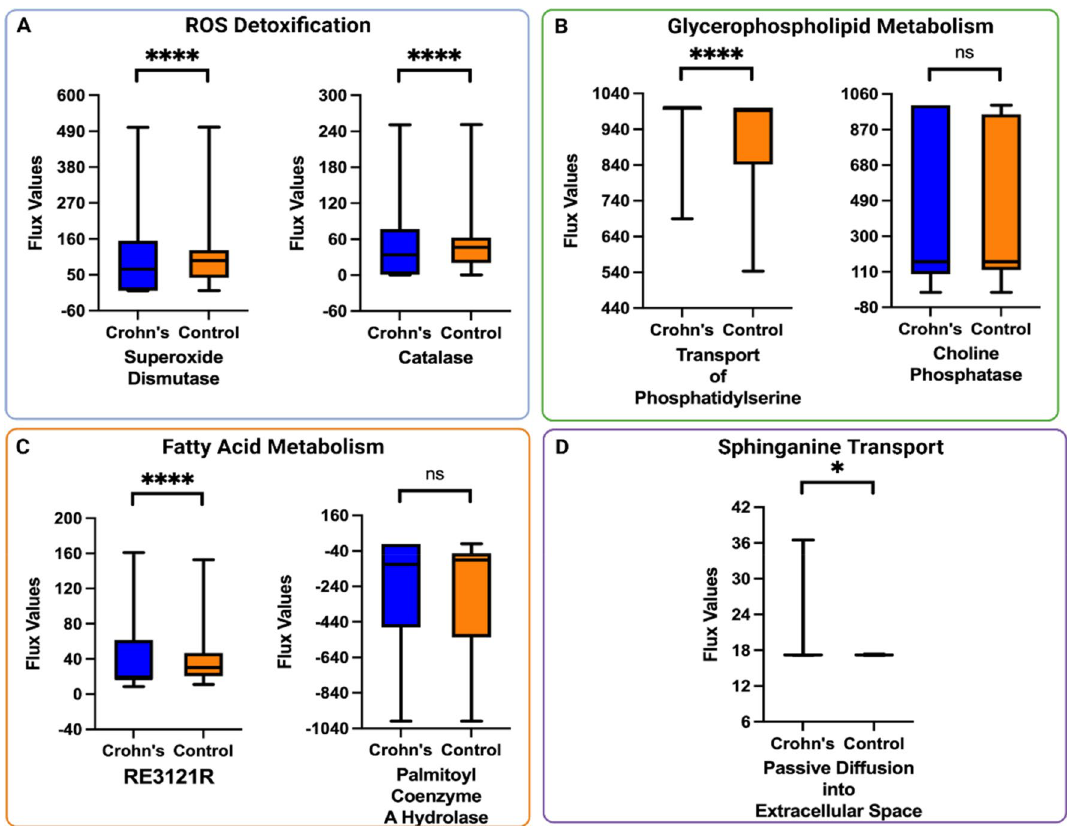
Figure 3 . Metabolic pathways with an altered flow in enteroids generated from patients with Crohn’s disease (CD) versus control patients: Our Flux Balance Analysis/Random Forest framework was applied to RNA sequencing data from enteroid models generated from n = 16 patients with Crohn’s disease and n = 12 healthy controls. After obtaining the list of top metabolic reactions that were altered between the CD and control groups, these reactions were grouped into "families" ( A–D ) based on the biological processes they were involved in. ( A ) ROS detoxification: superoxide dismutase and catalase, ( B ) Glycerophospholipid metabolism: choline phosphatase and the transport of phosphatidylserine. ( C ) Fatty acid oxidation: RE3121R is involved in pentaenoyl coenzyme A metabolism and palmitoyl coenzyme A hydrolase ( D ) Sphinganine transport. For all graphs, the x-axis describes the reaction that is altered between controls (orange) and diseased states (blue). The y-axis shows the flux values generated by RIPTiDe by analyzing the flow of metabolites through an ileal-specific metabolic network reconstruction. The scale of flux values (y-axis) varies with the reactions as the efficiency of different metabolic pathways in generating biomass varies in a given biological system. A Mann–Whitney U test was done to compare reactions that were varied between patients with Crohn’s disease and controls. The stars (*) are used to flag levels of significance. * p < 0.05, ** p < 0.01, *** p < 0.001, ns: not significant. ROS: reactive oxygen